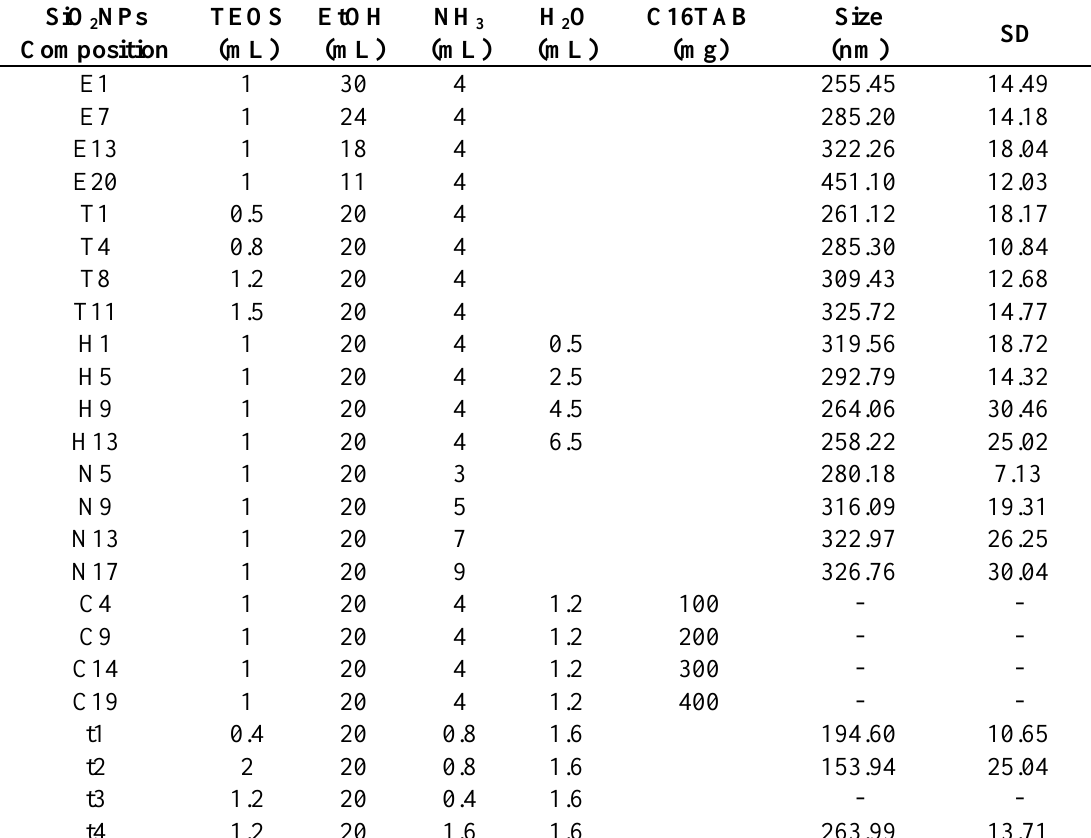
Table 1. SiO NPs chemical compositions prepared under basic medium and the average 2 particle sizes obtained ( n = 10).